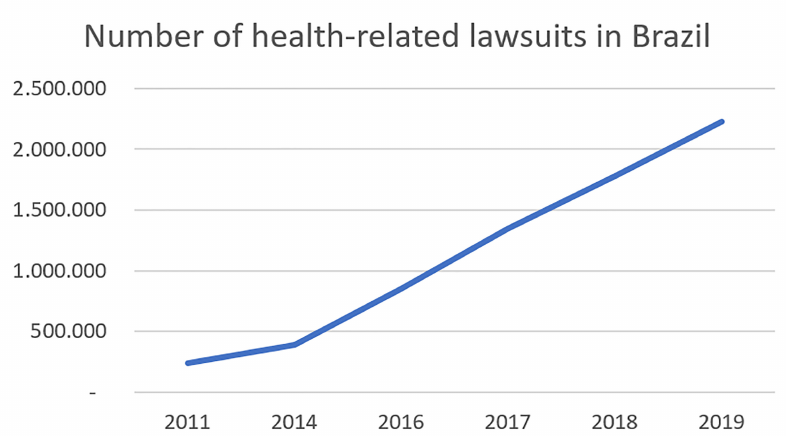
Figure 2 - Health-related lawsuits in Brazil from 2011 to 2019